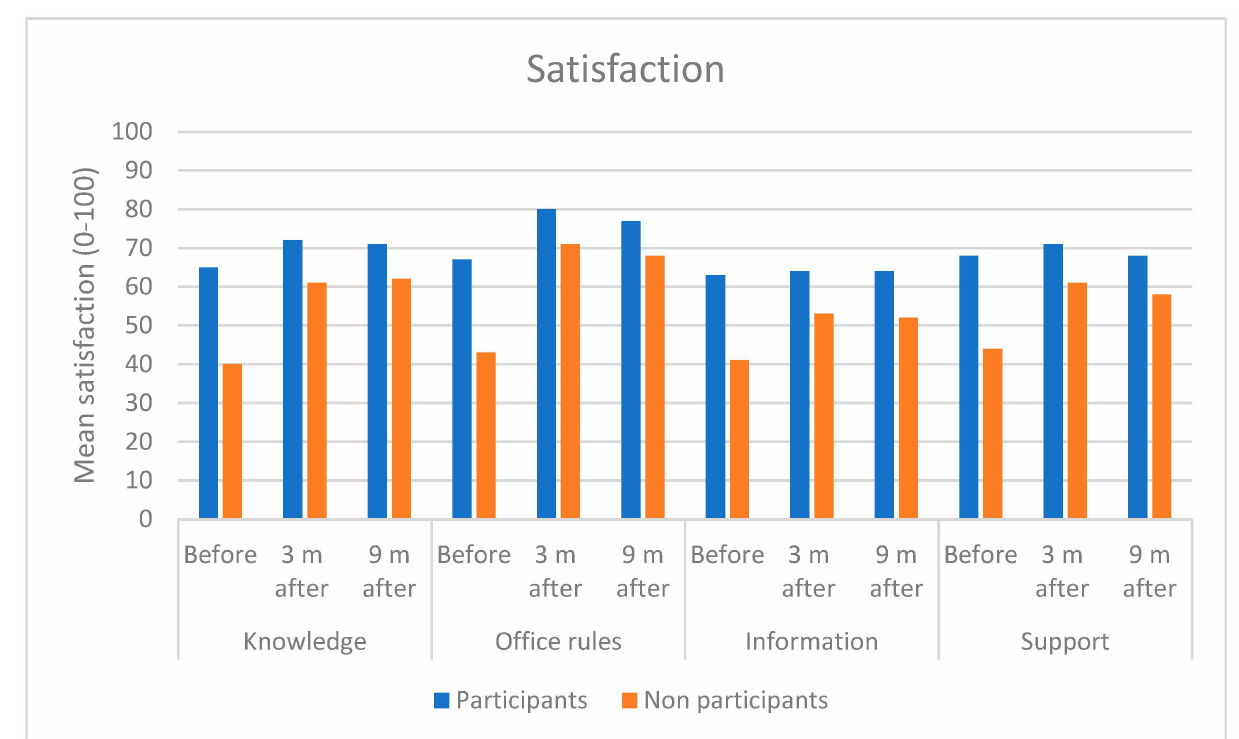
Figure 1. Mean values on a group level for satisfaction with knowledge, office rules, information implementation of activity-based